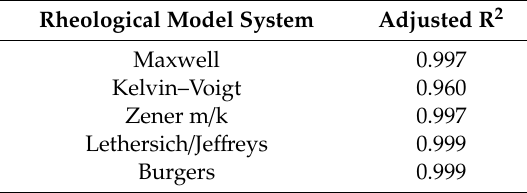
Table10. Applicabilityofdi ff erentmodelsystemsforthethermoplasticpoly-urethane(TPU)1180Amelt.